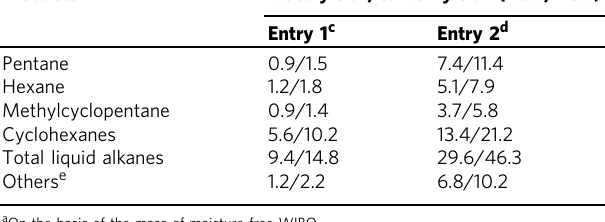
Table 1 HDO of water-insoluble wood and bark-derived WIBO over Pd/m – MoO 3 – P 2 O 5 /SiO 2